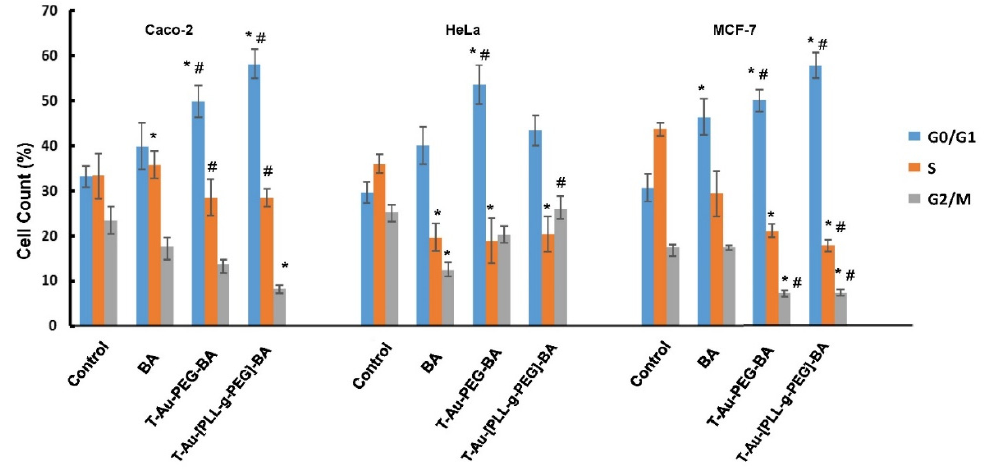
Figure 13. Graphical representation showing the effect of T-Au-PEG-BA, T-Au-[PLL-g-PEG]-BA and BA on cell cycle pro- gression. T-Au-PEG-BA; T-Au-[PLL-g-PEG]-BA = targeted nanocomplexes, and BA= free drug. Data is represented as mean ± SD ( n = 3). * vs. control, # vs. free drug at * p <